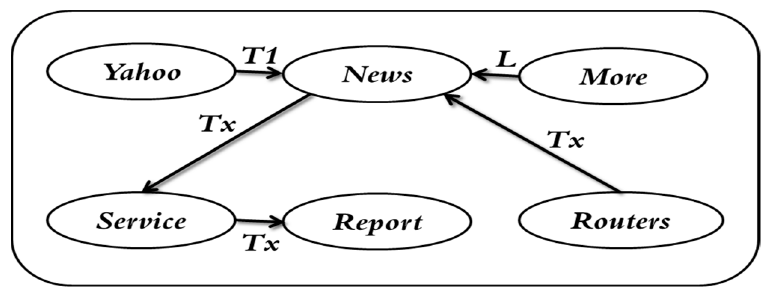
Figure 16. Graphical representation of web document clustering.